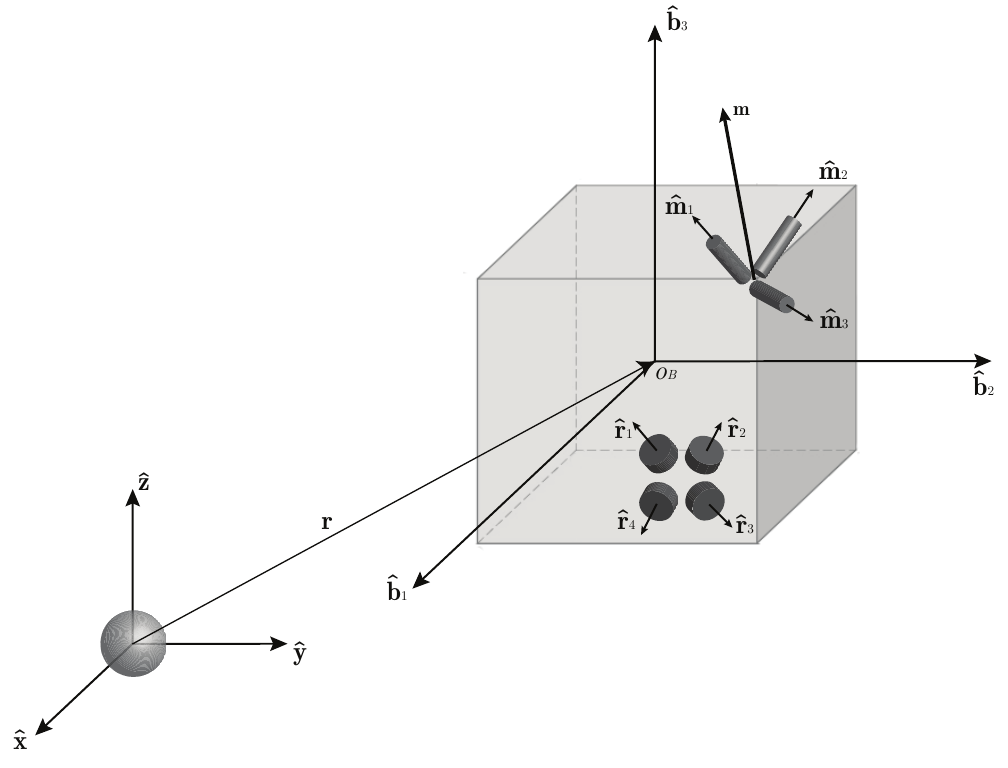
Figure 1. Problem setting of a spacecraft orbiting in LEO with four reaction wheels and three magnetic